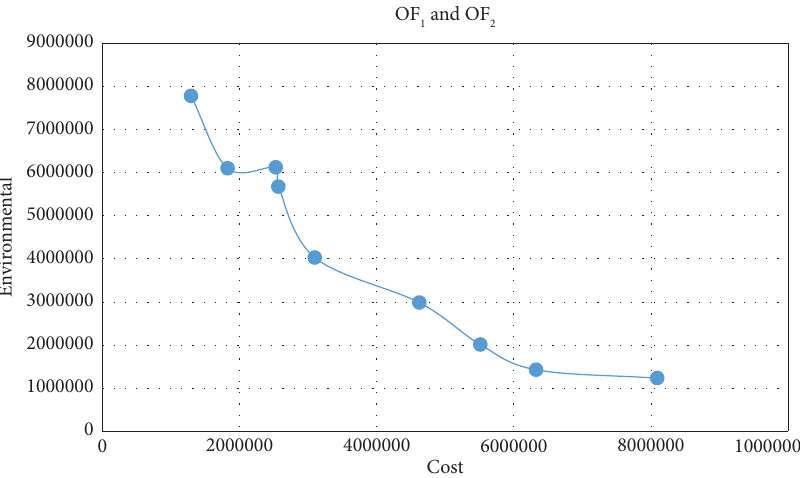
Figure 8: Pareto frontier of the case study.